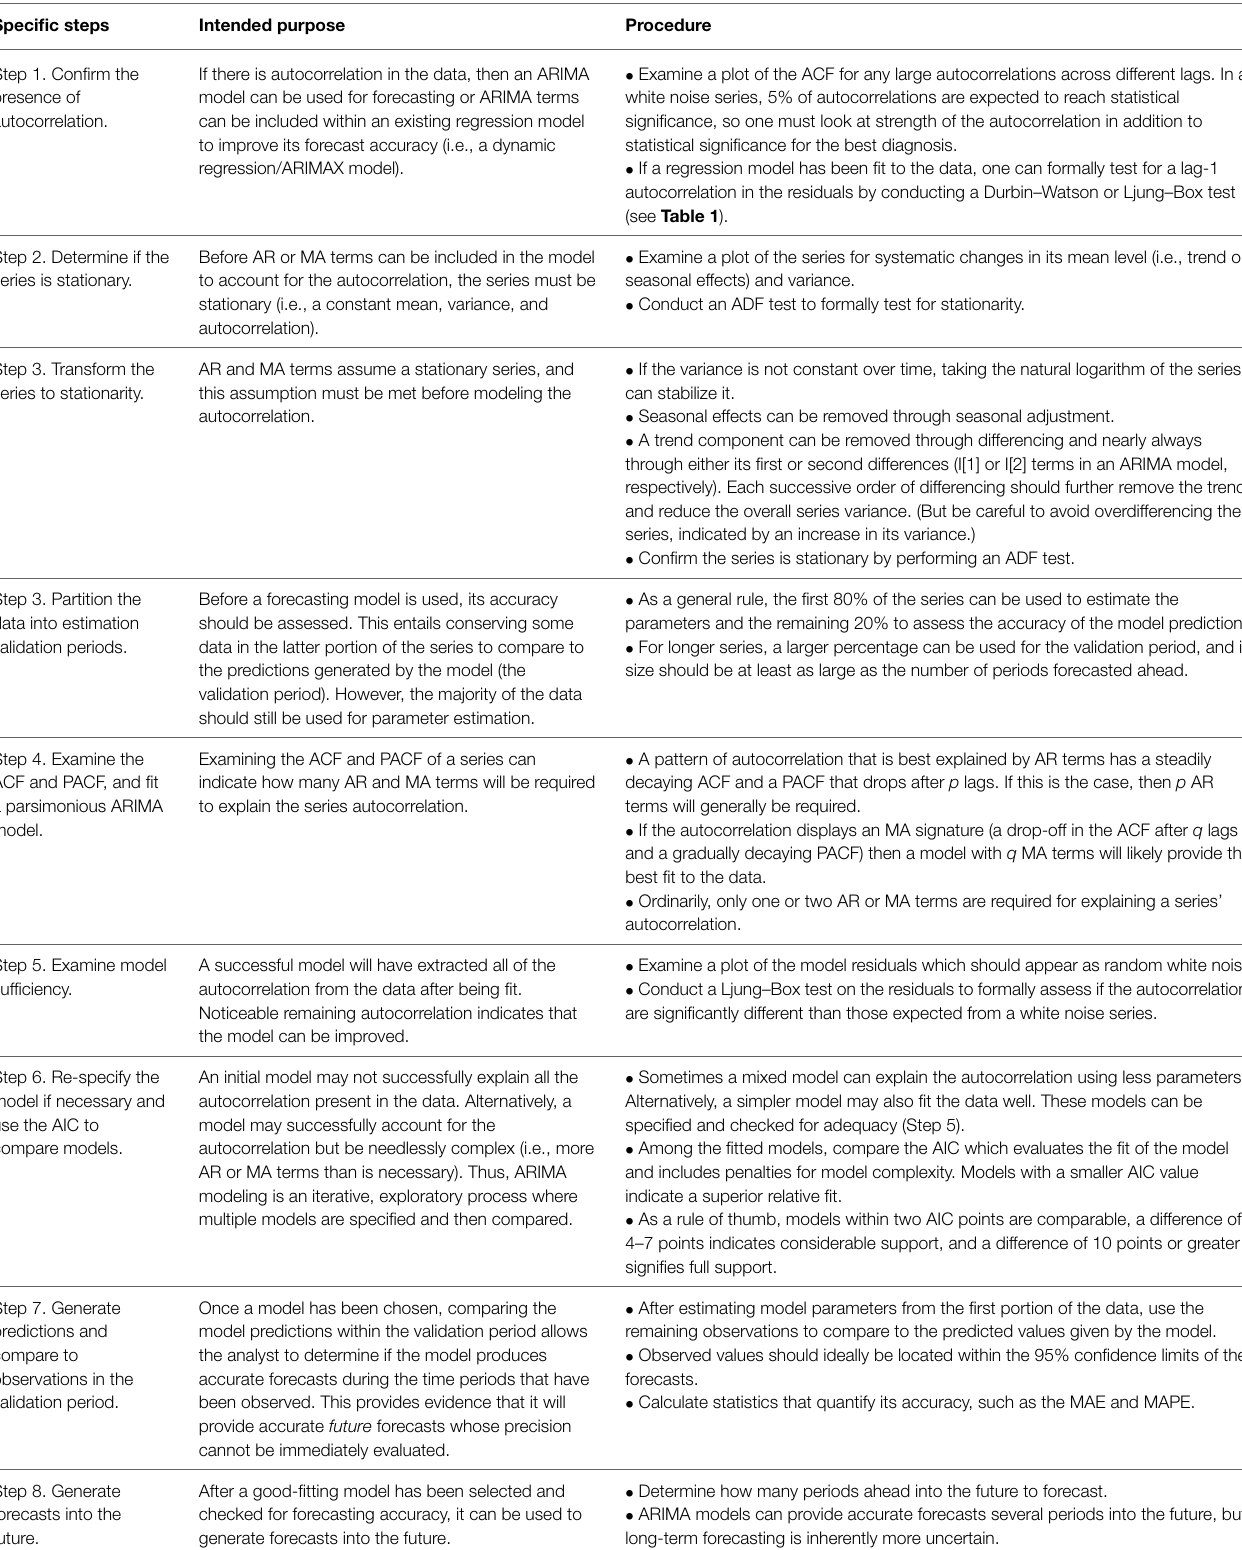
TABLE 3 | Steps for specifying an ARIMA forecasting